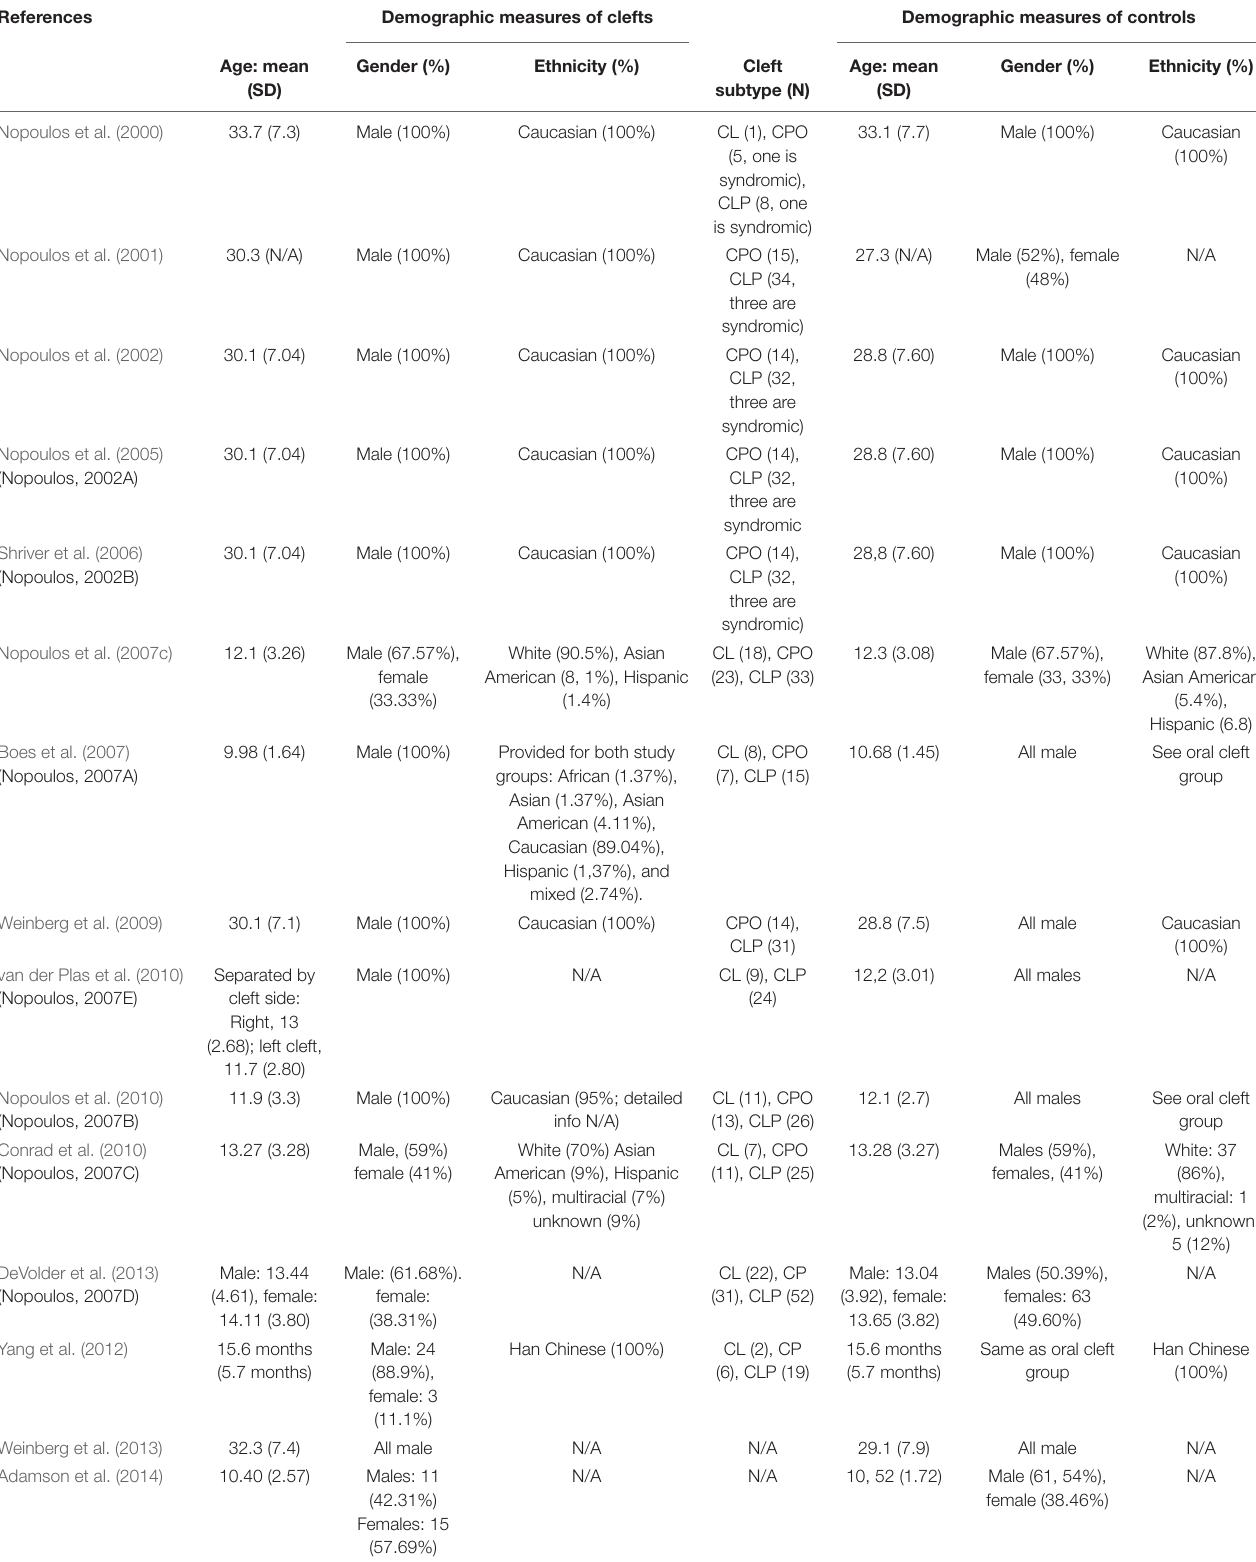
TABLE 1B | Demographic data of included